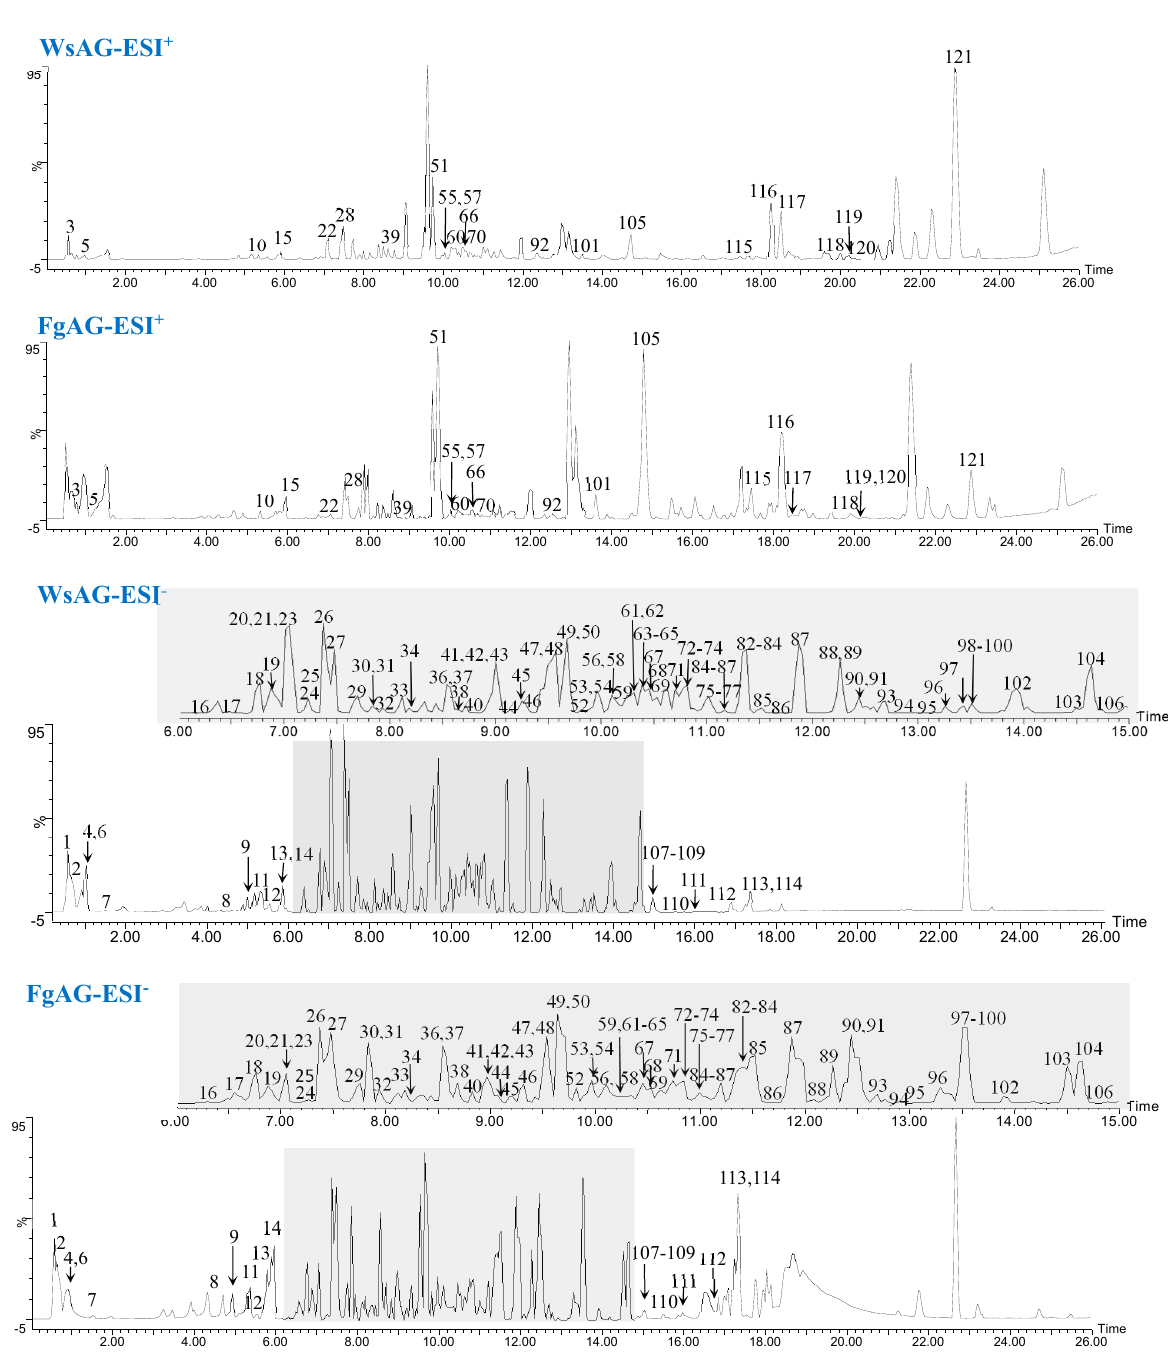
Figure 1. The representative base peak intensity (BPI) chromatograms of FgAG and WsAG in negative and positive